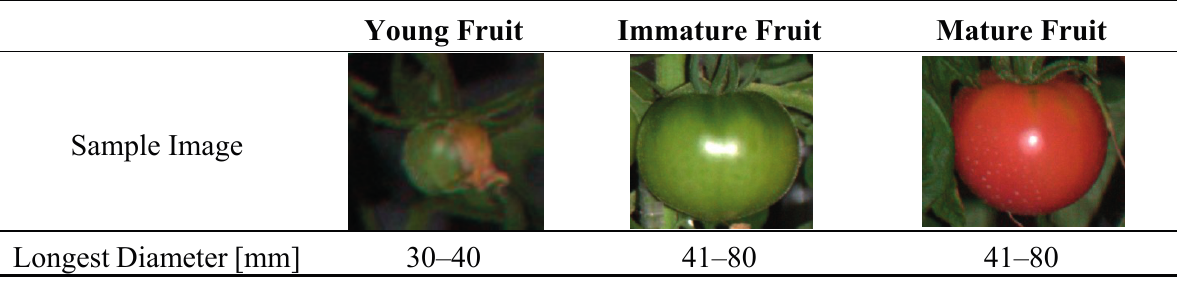
Figure 4. Definition of the growth stages of tomato fruit used in the present study. Tomato fruits were classified into three categories based on their color and